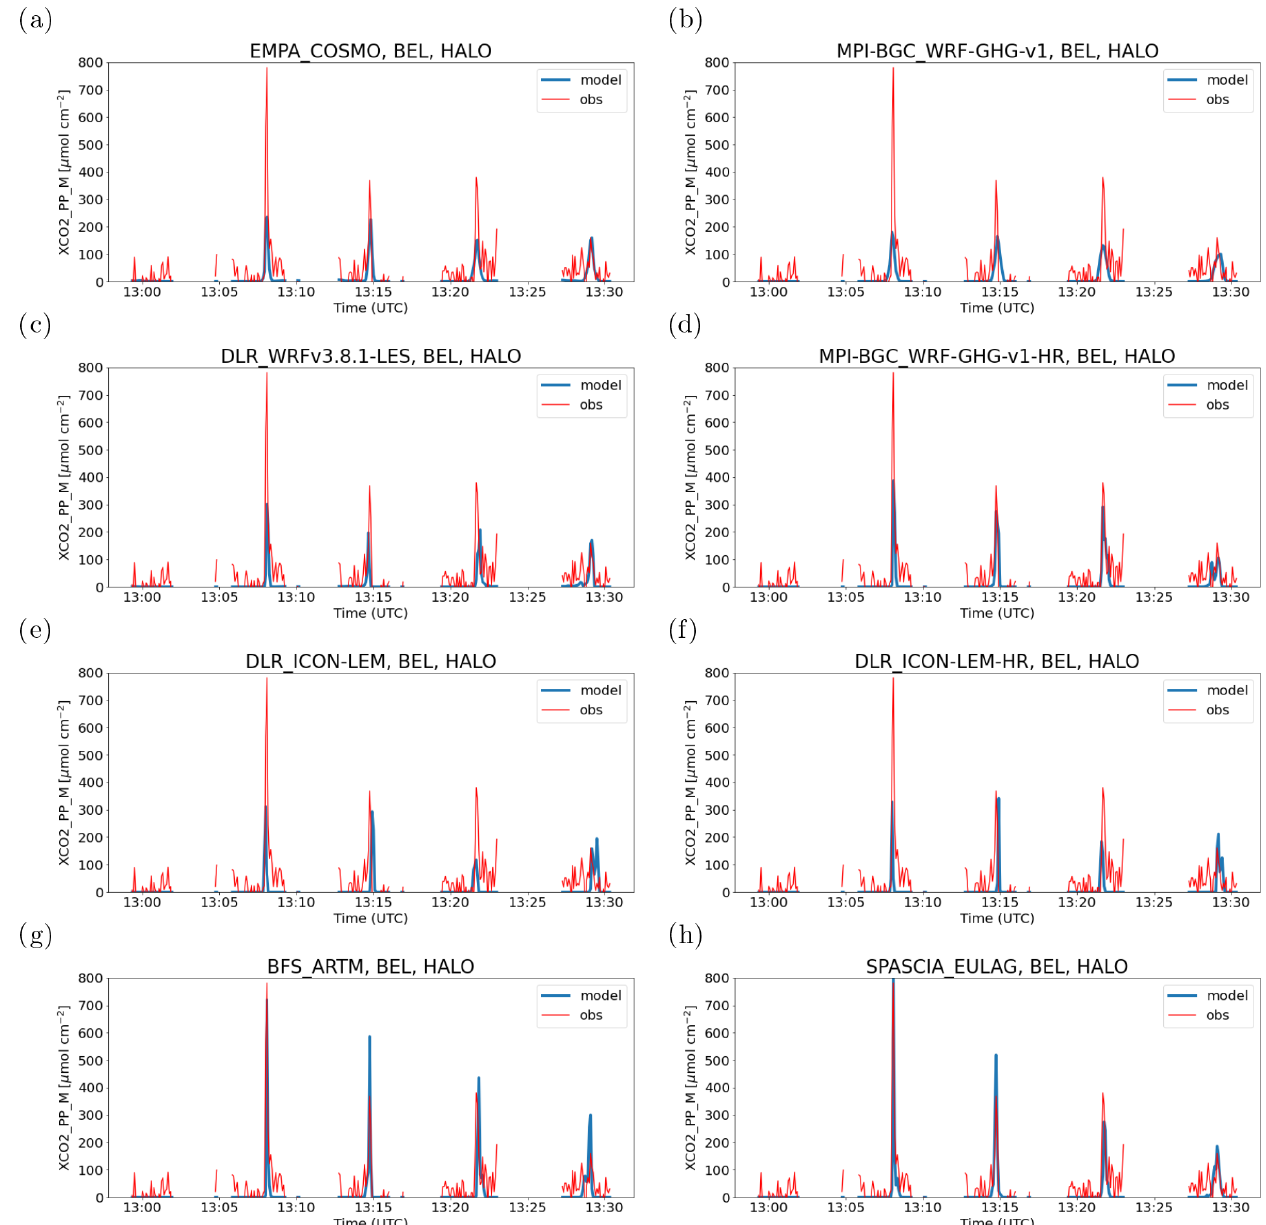
Figure 11. Time series of CO 2 (tracer CO2_PP_M) column enhancements simulated and observed by CHARM-F along the HALO flight at Bełchatów on 7 June